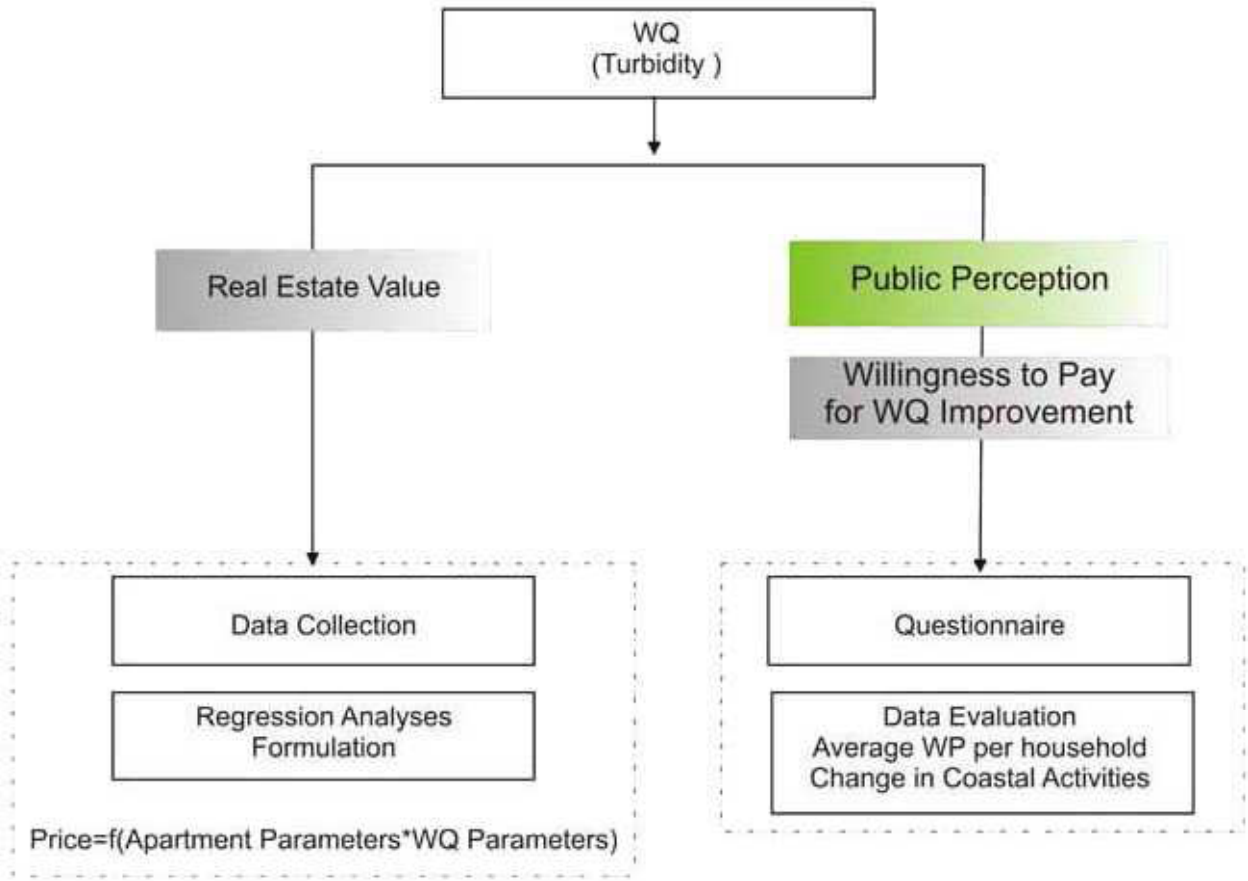
Fig. 8. A diagram of the structure of data and methods used for the social and economic components of the